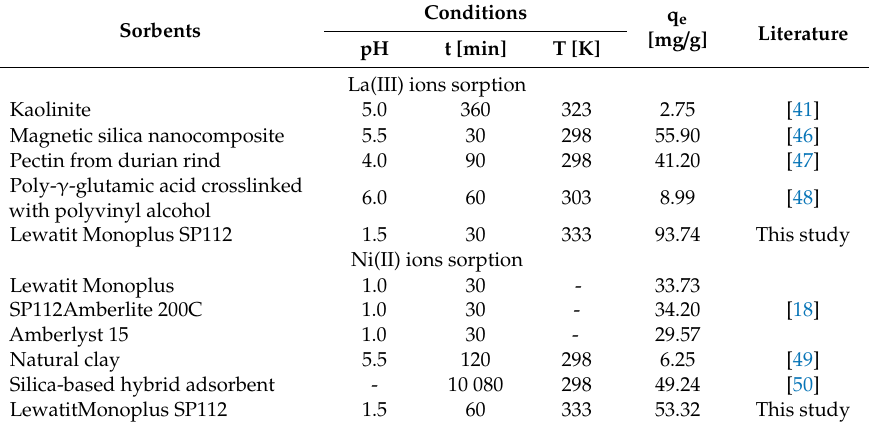
Table 4. Comparison of La(III) and Ni(II) ions sorption capacities by other